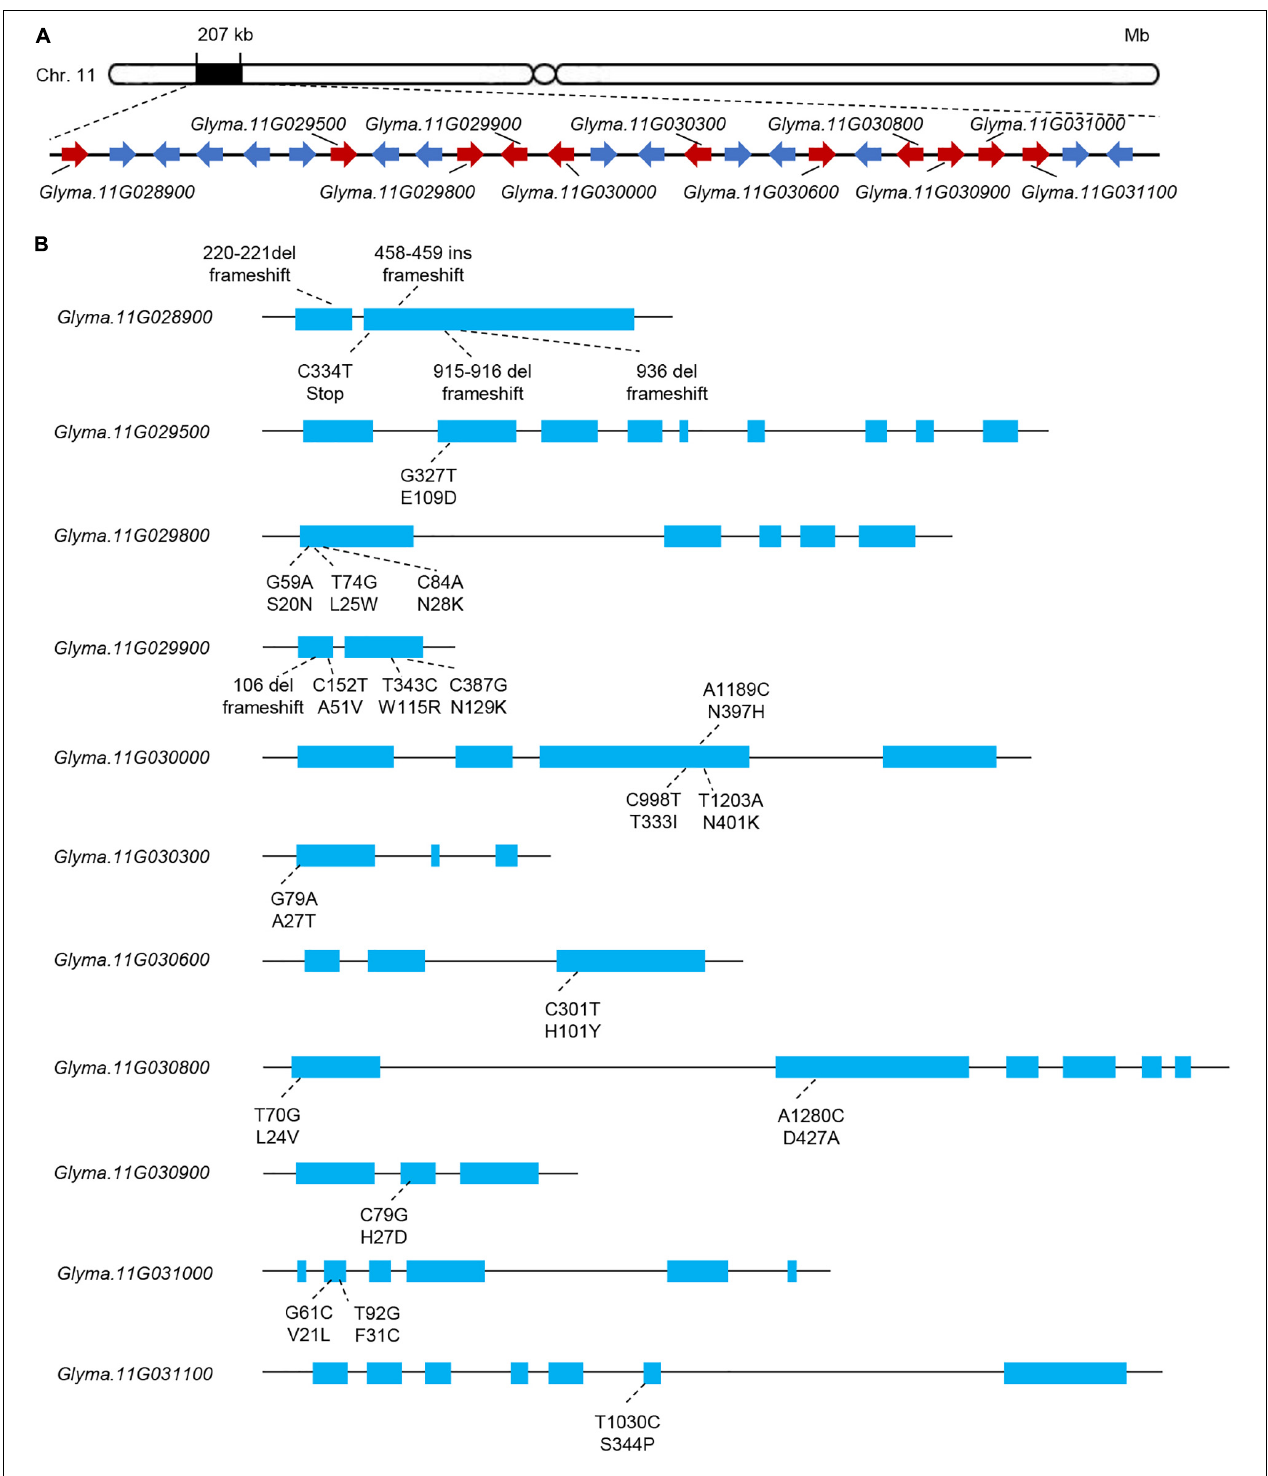
FIGURE 4 | Polymorphism analysis of the candidate genes in the 207-kb region of interest. (A) Gene structure of R smv -11 showing the location of the candidate genes. Red represents genes with different sequences between parents. (B) Gene structure and variation information of candidate genes with different sequences between